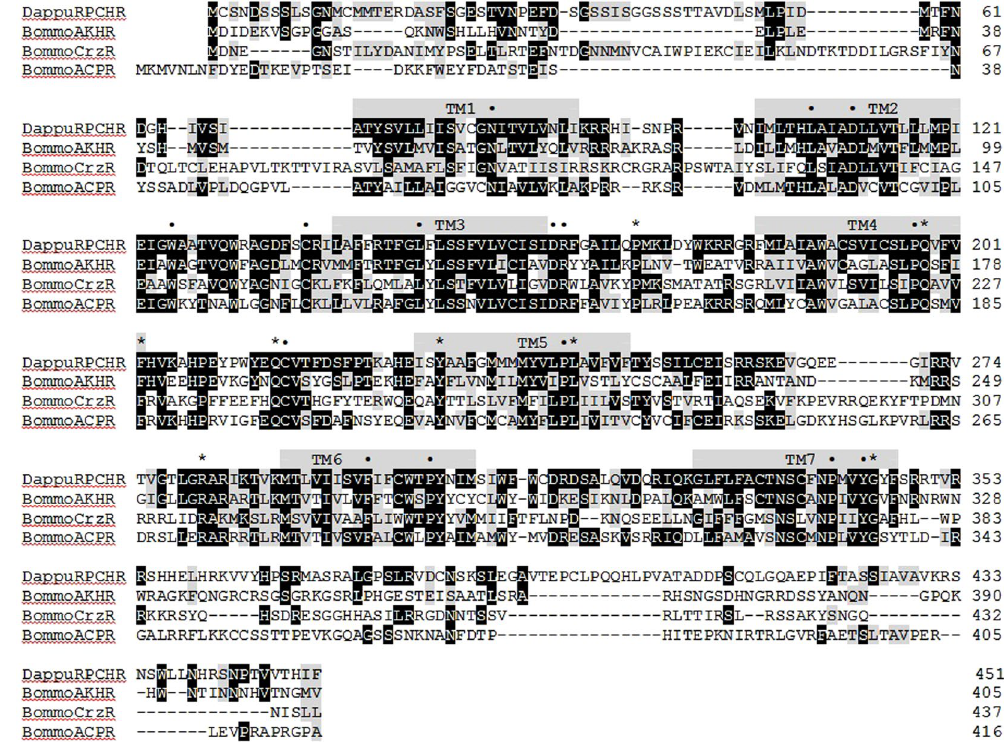
Figure 2. Amino acid sequence alignment of the Dappu-RPCHR (GenBank acc. no. KY426816 ), Bommo- AKHR (GenBank acc. no. NP_001037049 ), Bommo-CrzR (GenBank acc. no. NP_001127719 ) and Bommo- ACPR (GenBank acc. no. ACT79362 ). The amino acid position is indicated on the right. Identical residues between the Dappu-RPCHR and any of the other receptors are highlighted in black, and conservatively substituted residues in grey. Dashes indicate gaps that were introduced to maximise homologies. Putative transmembrane regions (TM1–TM7) are indicated by grey bars. Conserved amino acids for the rhodopsin- like GPCRs are indicated by a dot ( • ), whereas conserved amino acids for the GnRH receptor subfamily are indicated by asterisk. Abbreviations used: Dappu, Daphnia pulex ; RPCHR, red pigment concentrating hormone receptor; Bommo, Bombyx mori ; AKHR, adipokinetic hormone receptor; CrzR, corazonin receptor; ACPR, AKH/corazonin-related peptide